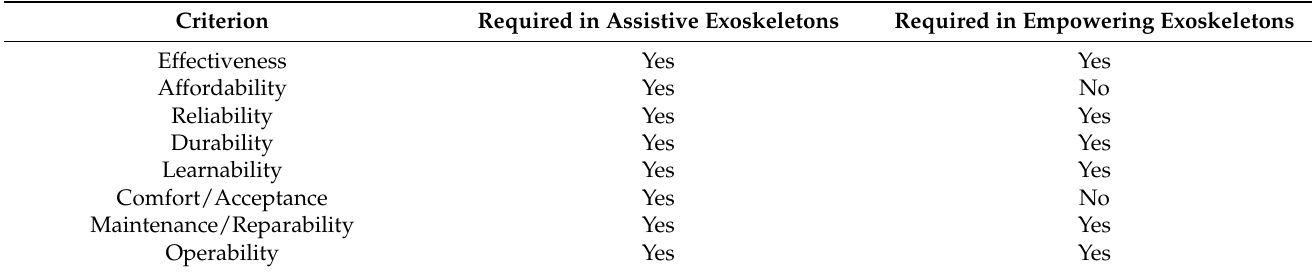
Table 2. Applicability of requirements to exoskeleton